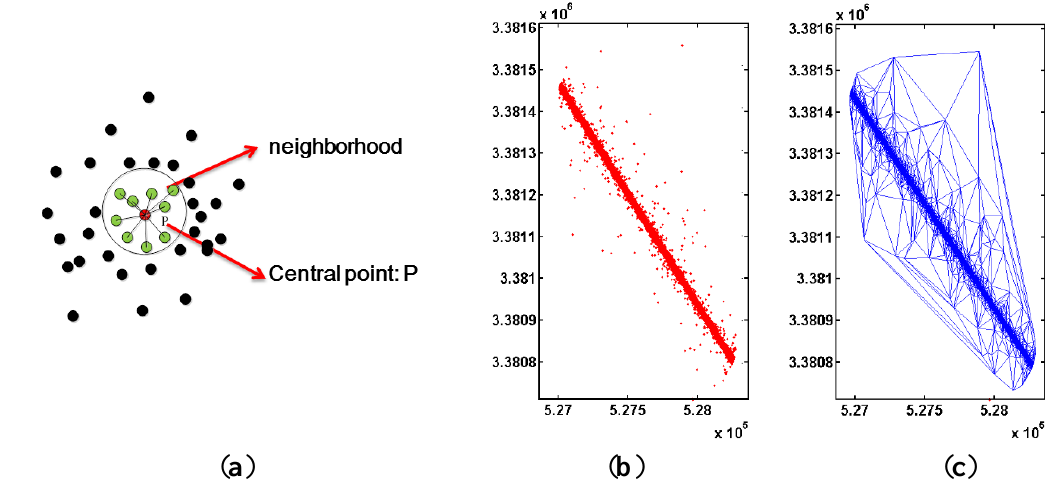
Figure 2. Trajectories optimization. ( a ) shows the distribution of tracking points, p is the central point and the circle in (a) is the neighborhood of p ; ( b )indicates a subset of tracking points and be denoted as A ; ( c ) is the Delaunay triangulation of A